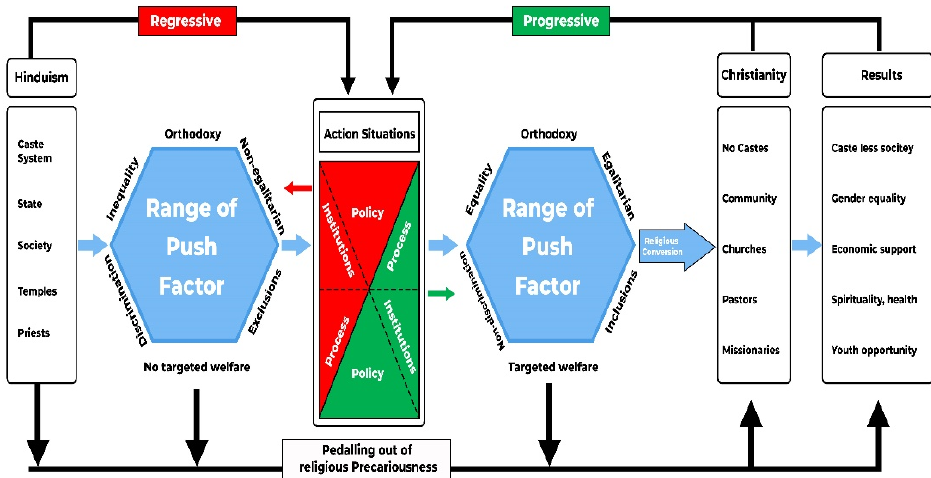
Figure 2. Summary of the Findings.